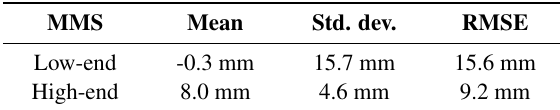
Figure 4. GCP in the point cloud data coloured based on the intensity value of the low-end system (left) and high-end system (right) Table 6. Summary of the relative accuracy